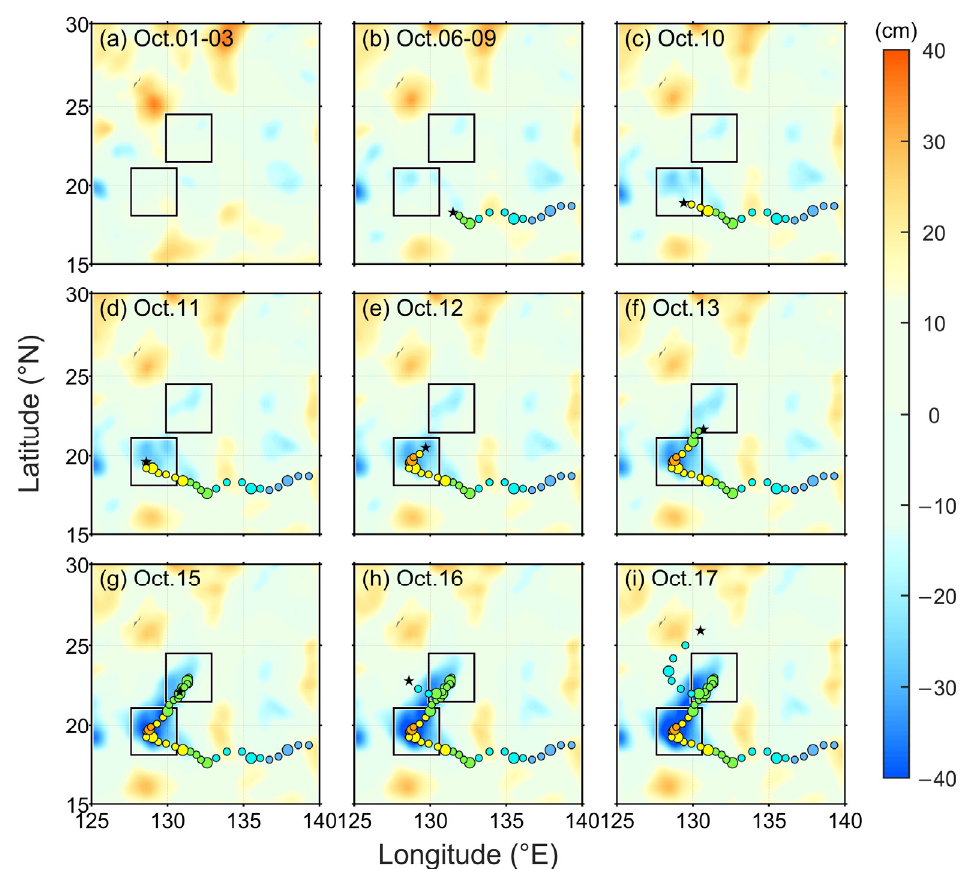
Figure 3. Spatial distribution of the SSHA evolution before, during, and after the passage of Typhoon Prapiroon. ( a ) The pre-typhoon SSHA, averaged on 1–3 October; ( b ) the SSHA in the study area during Prapiroon, averaged on 6–9 October; ( c – f ) the SSHA in the study area during Prapiroon from 10 October to 13 October; and ( g – i ) the SSHA in the study area during Prapiroon from 15 October to 17 October. Two solid boxes are the two focused domains of the sudden-turning stages of the typhoon, denoted A1 and A2. The coloured lines and dots represent the track and intensity of the typhoon. The black star in each figure indicates the last position where the typhoon arrived on that day.